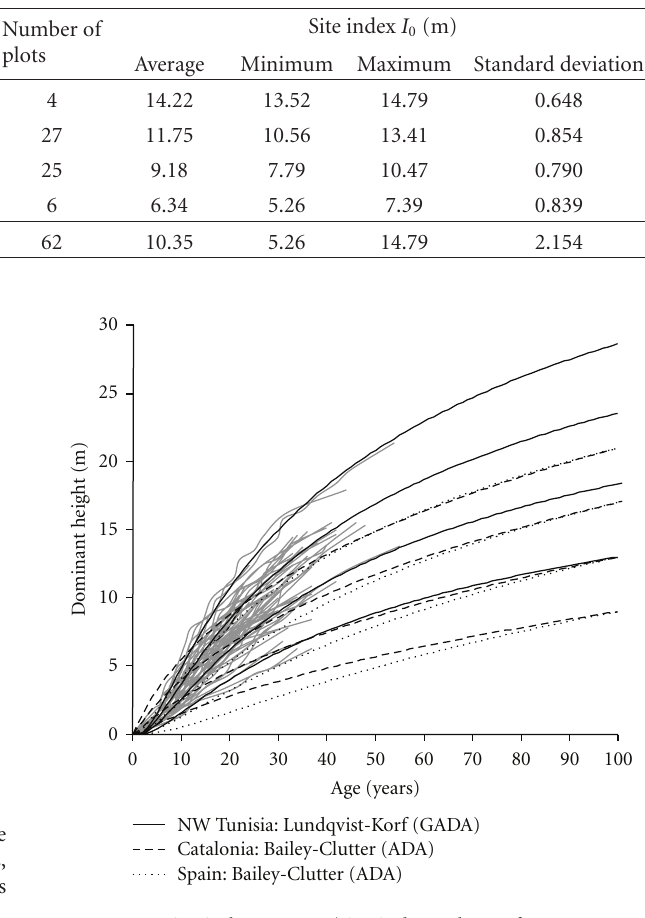
Figure 10: Site index curves (site index values of 6, 9, 12, and 15m at reference age of 30 years) (Lundqvist-Korf: GADA) overlaid on the trajectories of the observed dominant heights over time for Pinus pinea in northwest of Tunisia , superposed with national site index curves (Bailey-Clutter: ADA) for Pinus pinea in Spain [1] and site index curves (Bailey-Clutter: ADA) for Pinus pinea in Catalonia [2] both with site index values of 9, 13, 17, and 21 m at reference age of 100